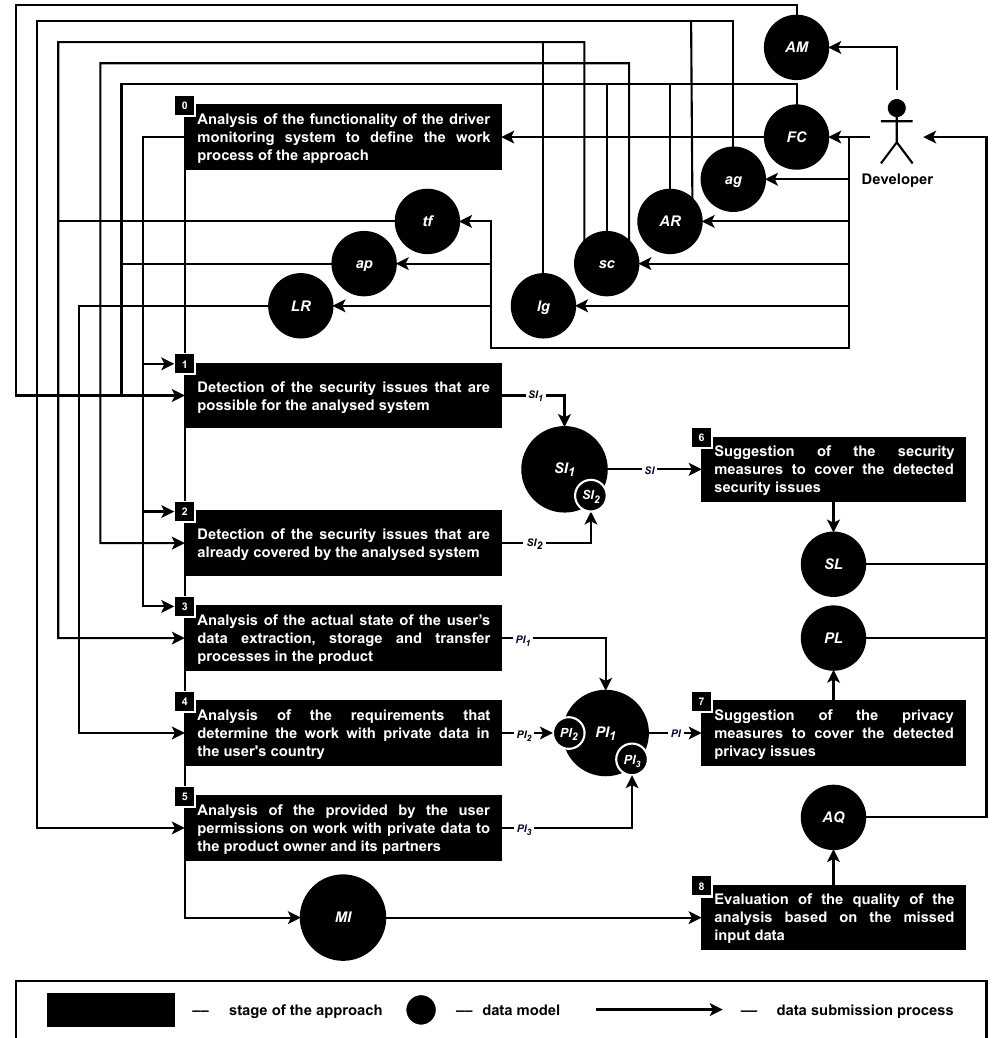
Figure 2. The approach for the security and privacy analysis of smartphone-based driver monitoring systems from the developer’s point of